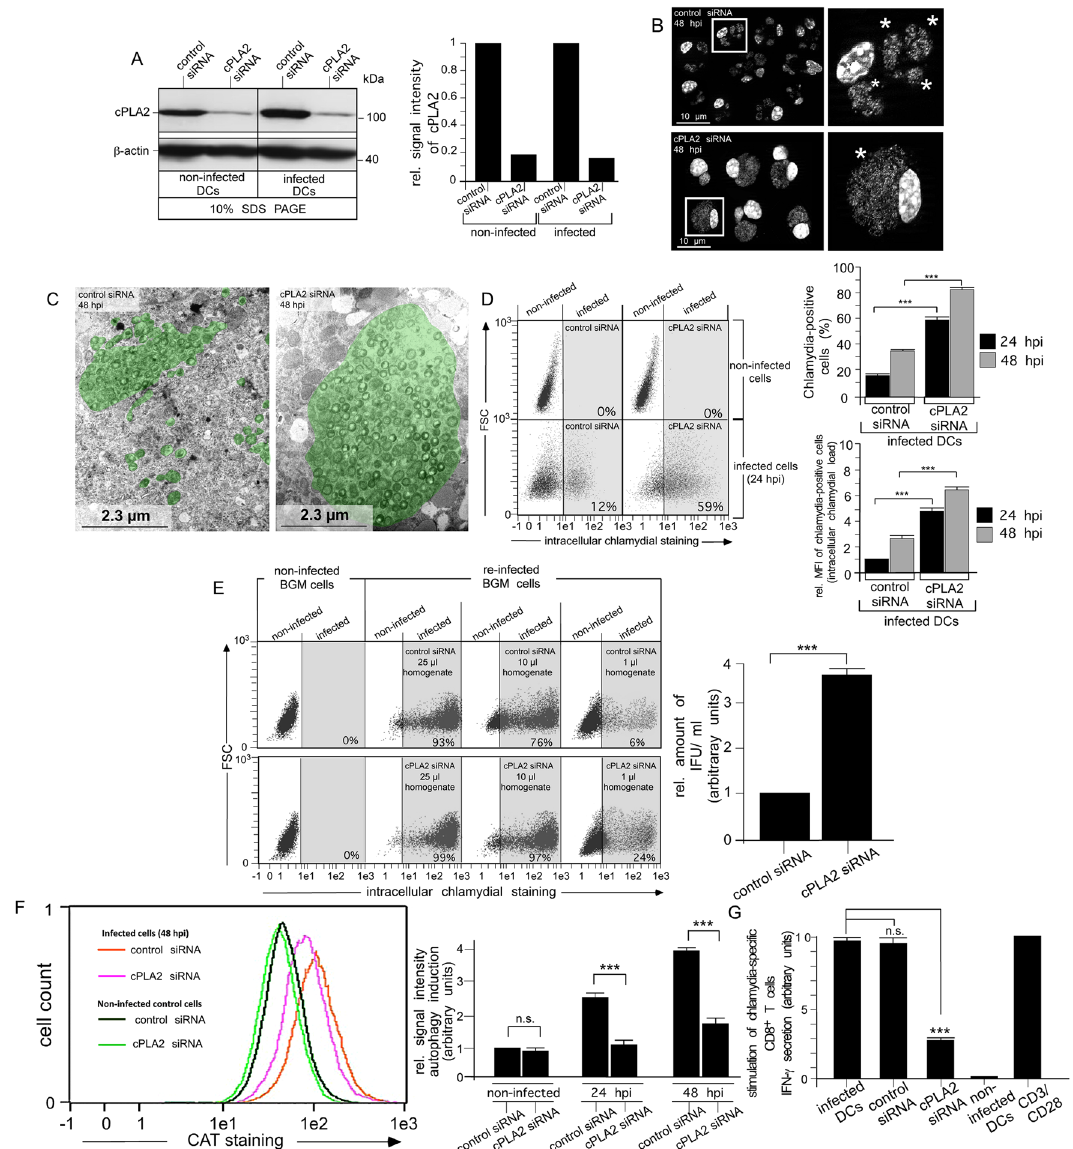
Figure 3. Silencing of cPLA2 interferes with inclusion breakdown and infection-induced autophagy in DCs. ( A ) cPLA2-silenced DCs were incubated or not with chlamydia for 48 h. siRNA silencing was demonstrated by densitometrically analysed Western blots (left and right, cPLA2 is visible as single band on 10% SDS gels) ( B ) cPLA2-silenced and control DCs were infected or not with chlamydia. Nuclei and inclusions were labelled with DAPI. Chlamydial structures are indicated by asterisks. ( C ) Electron photomicrographs of siRNA-treated infected DCs (48 hpi) (control siRNA, left and cPLA2 siRNA, right) Chlamydia and inclusions are artificially coloured green. ( D ) Infected cells were analysed by flow cytometry using the IMAGEN kit. The left panel shows a representative analysis at 24 hpi. Summarised Data (right) from three independent experiments (24 and 48 hpi) show the number of chlamydia-positive cells, as well as the bacterial load (MFI) of infected cells. The MFI for infected cell cultures (24 hpi) was set to 1 arbitrary unit. ( E ) DCs were infected for 48 h. Cell homogenates were titrated on BGM cells (left) to determine the number of recoverable infectious chlamydia. IFU as the measure of infectivity were determined by flow cytometry using the IMAGEN kit. IFU/ml obtained for siRNA-treated control cells was set to 1 arbitrary unit. Pooled data from three separate experiments are shown. ( F ) Cells siRNA-silenced for cPLA2 were incubated or not with chlamydia for 24 and 48 h. Autophagy induction was analysed by using CytoID staining (CAT). The left panel shows a representative flow cytometry analysis (48 hpi). Summarised data from three independent experiments (non-infected, 24 and 48 hpi) are shown as bar graphs with arbitrary units (right). Data were normalised such that the value obtained for non- infected cells (control siRNA) was set to 1. ( G ) DCs were siRNA-silenced for cPLA2 and incubated or not with chlamydia. DCs were cocultured with chlamydia-sensitised CD8 + T cells for 48 h. IFN- γ secretion by CD8 + T cells was assayed by ELISA. Results are depicted as in Fig. 1G. Statistical analysis in ( D – G ) was performed as described in Methods (n.s.: not significant; *** p < 0.001 versus controls; n =